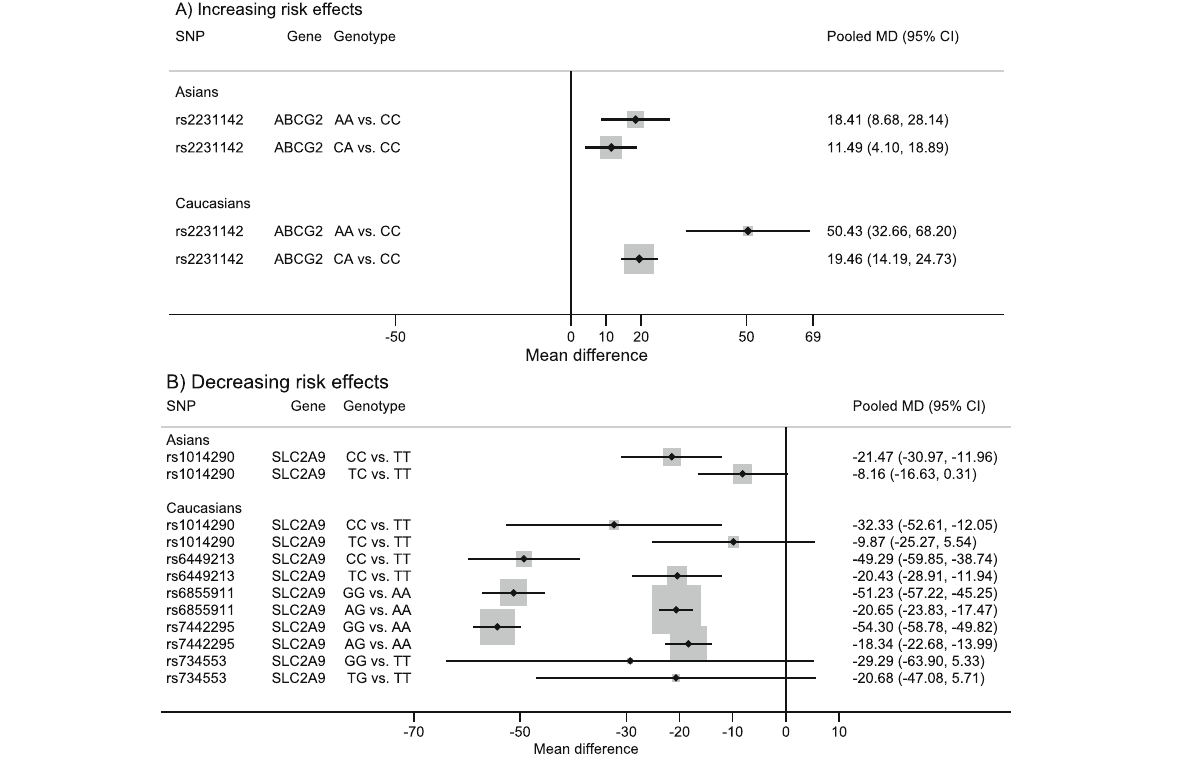
Fig. 4 Summary of pooled genotype effects on mean difference of serum urate. a Increasing risk effects b Decreasing risk effects. ABCG2 ,